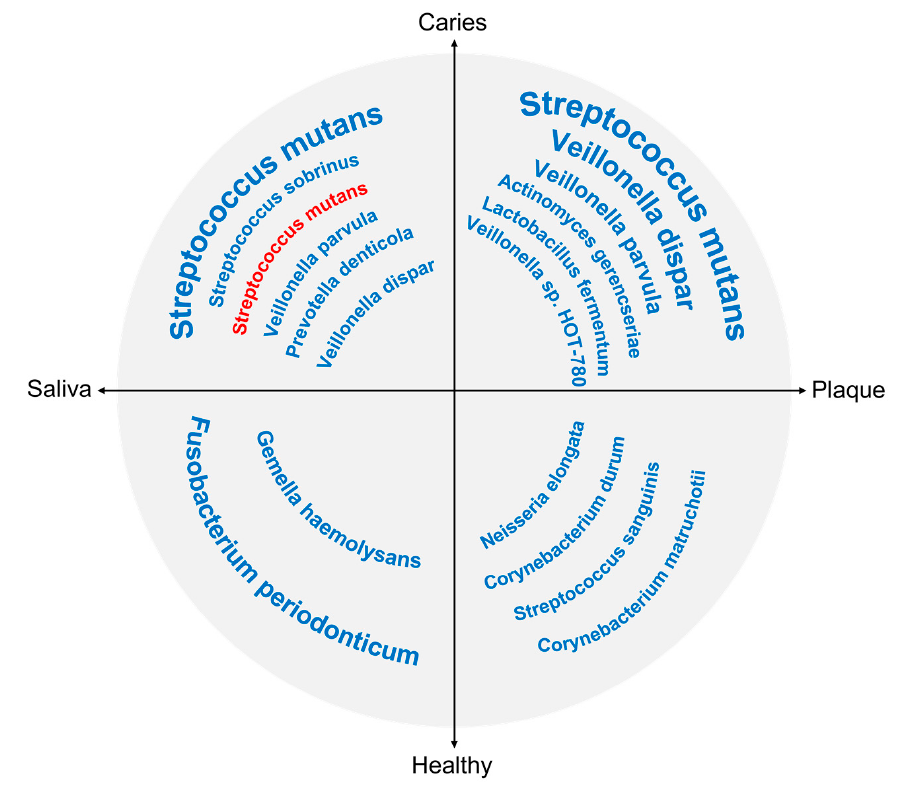
Figure 2. Common bacteria affecting development of dental caries. Bacterial species with significantly higher abundances in caries-affected status or in healthy status from supragingival plaque or saliva samples. Each quadrant presents a different sample type; for example, the top right quadrant denotes plaque samples from caries-affected subjects. Font size is positively proportional to the frequency of detection. Font color is to distinguish age groups: blue for children and red for adults.